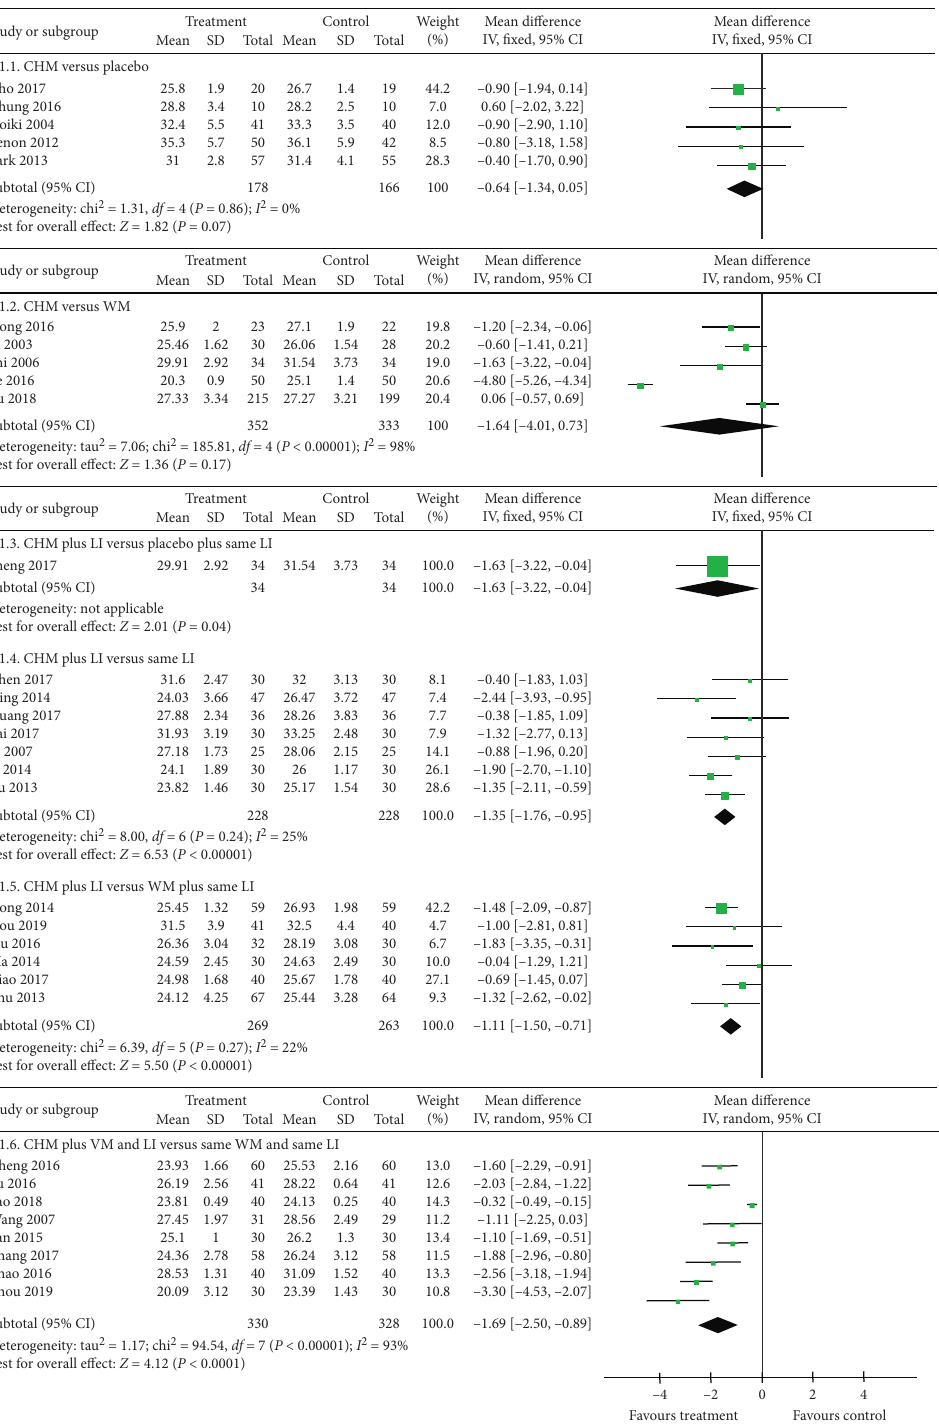
Figure 5: Comparison of body mass index between Chinese herbal medicine treatment and control